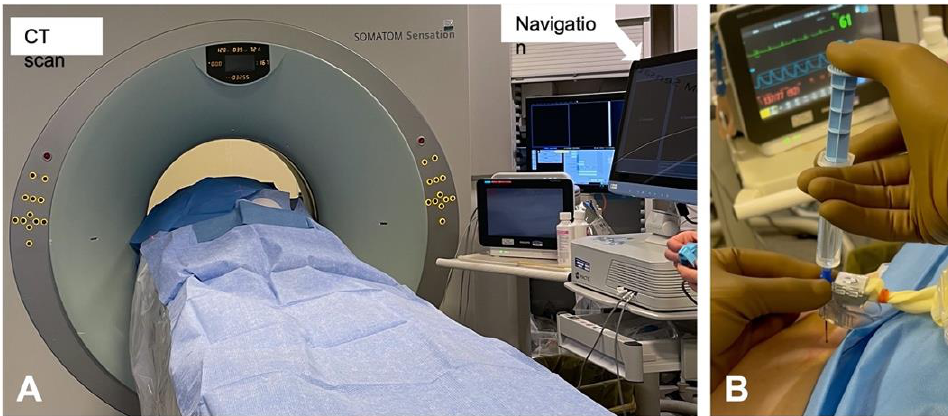
Figure 1. Representative images of ( A ) intraoperative setting for CT and navigation guided epidural injection and ( B ) navigated needle insertion.